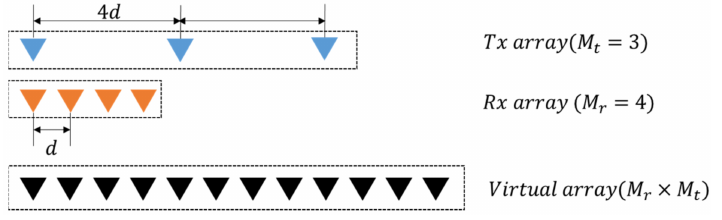
Figure 1. Virtual array antenna by MIMO.